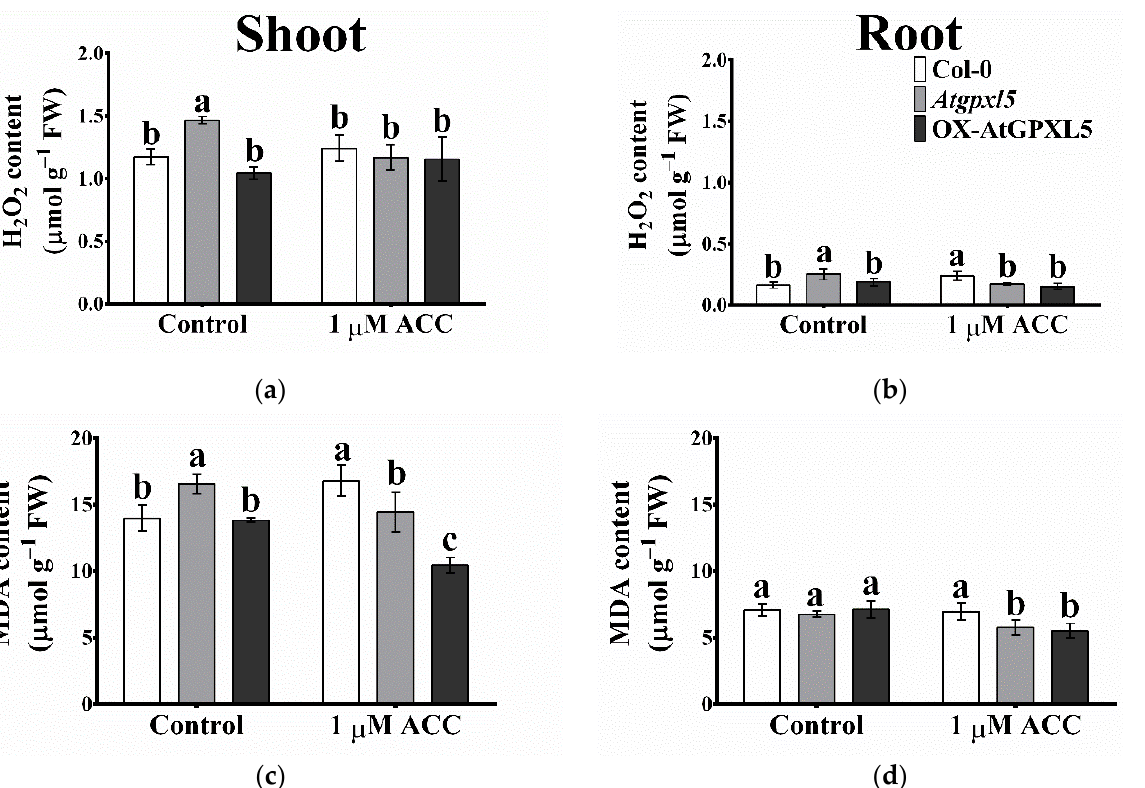
Figure 6. Effect of one-day 1 µ M ACC treatment on the hydrogen peroxide (H 2 O 2 ) ( a , b ) and malondialdehyde (MDA) contents ( c , d ) in shoots ( a , c ) and roots ( b , d ), respectively, of 6-week-old Arabidopsis thaliana wild type (Col-0), Atgpxl5-1 insertional mutant ( Atgpxl5 ) and AtGPXL5-overexpressing (OX-AtGPXL5) plants. The data are presented by mean values ± SD, n = 3. Data were analysed using one-way ANOVA followed by Duncan’s test. Different letters represent data considered statistically significant at p ≤ 0.05.